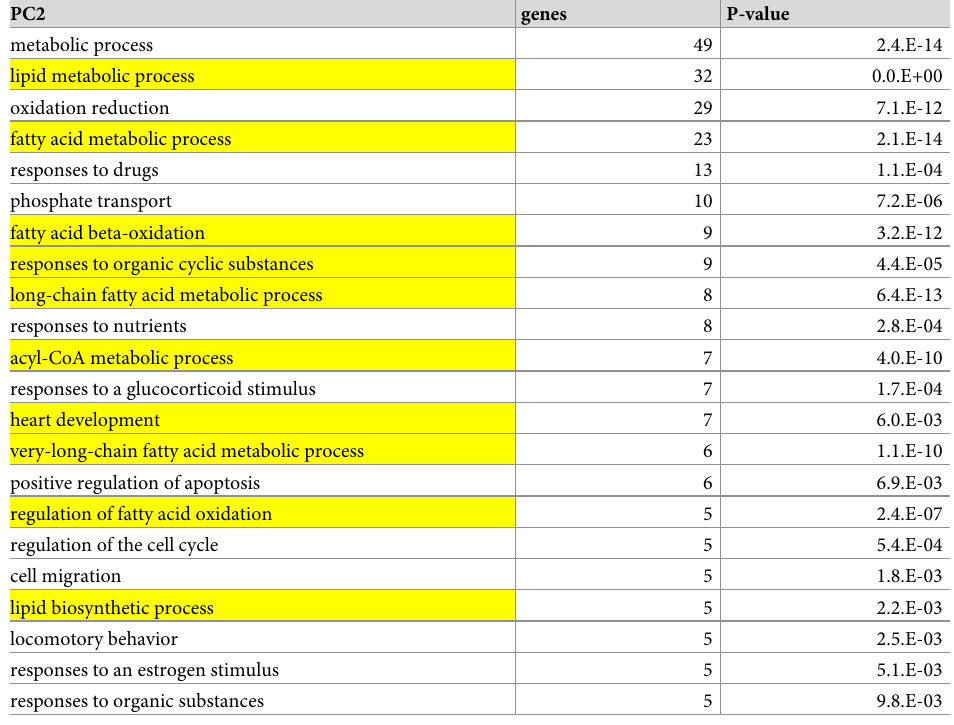
Table 2. Over-represented gene ontology involving hepatic genes expressed differently among groups (PC2).